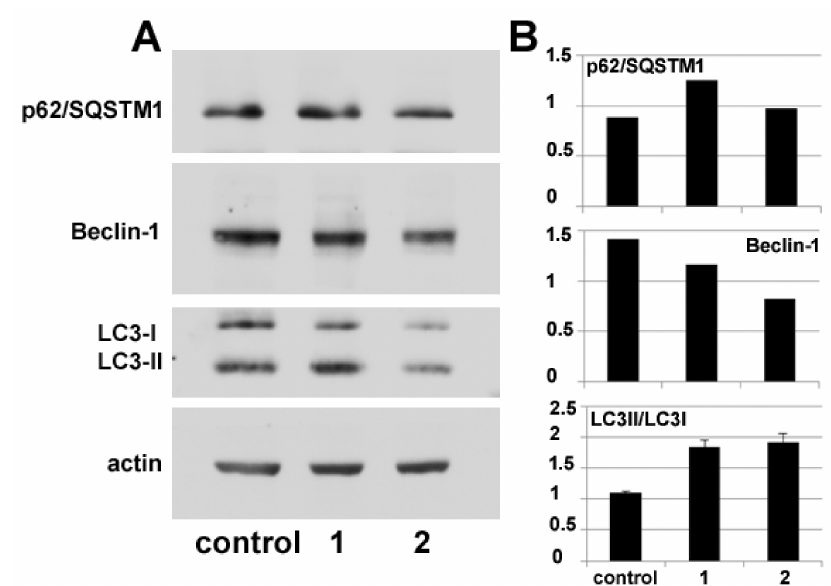
Figure 6. ( A ) Representative immunoblot analysis of autophagy molecular markers in MDA-MB-231 cells cultured in control conditions or exposed to either 1 or 2 for 24 h. ( B ) Histograms showing the relative extent of marker quantitation after normalization with actin as the loading control. The results are expressed as the mean ± SEM of triplicate assays. All p values were <0.05 if compared to controls.